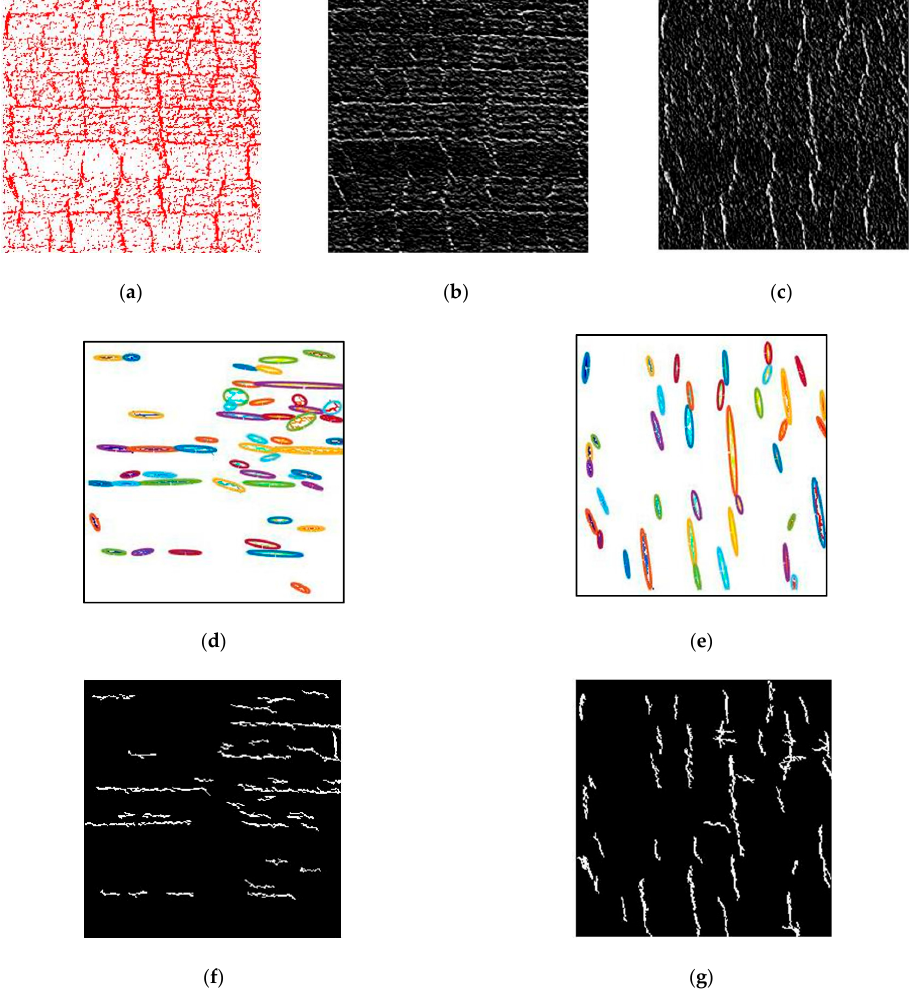
Figure 15. Evaluation of the algorithm on surface images of earthen heritage. ( a ) Image 2, ( b ) horizontal edge map, ( c ) vertical edge map, ( d ) horizontal CCs (area > 30 pixels), ( e ) vertical CCs (area > 30 pixels), ( f ) architectural feature map and ( g ) crack map.